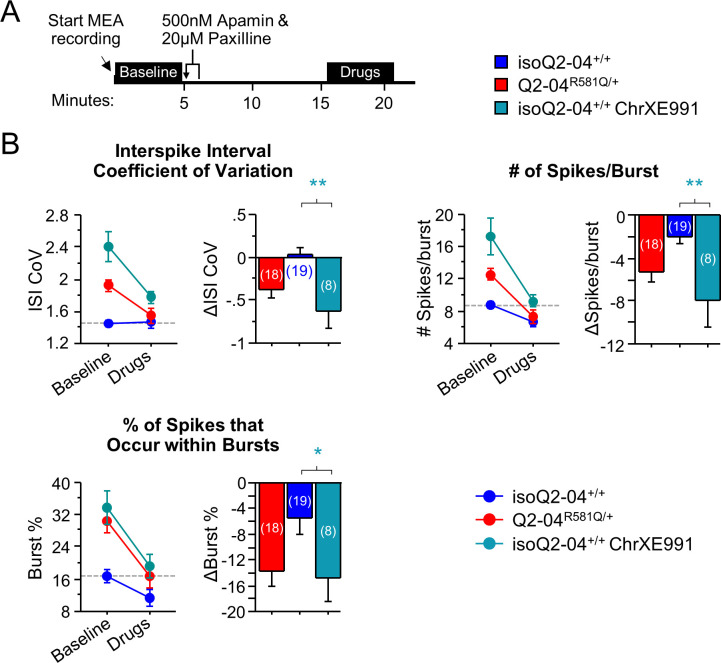
Effects of acute paxilline/apamin treatment on chronically XE991-treated control neurons.(A) Experimental protocol. On day 32, apamin (500 nM) and paxilline (20 µM) were added to MEAs after 5 min of baseline spontaneous recordings. The effect of drugs was measured after 10 min of continuous recording for 5 min. (B) The magnitude by which apamin and paxilline reduced ISI CoV, spikes/burst and burst % was significantly larger in chronically XE991-treated isoQ2-04+/+ neurons compared to untreated isoQ2-04+/+ neurons (t-test: **p=0.0019, **p=0.0011 and *p=0.0482, respectively). A dotted line is drawn through the mean baseline values measured for isoQ2-04+/+ neurons before acute application of apamin and paxilline. Teal * indicate significant difference between chronically XE991-treated isoQ2-04+/+ and untreated isoQ2-04+/+ neurons. Values displayed are mean ± SEM.